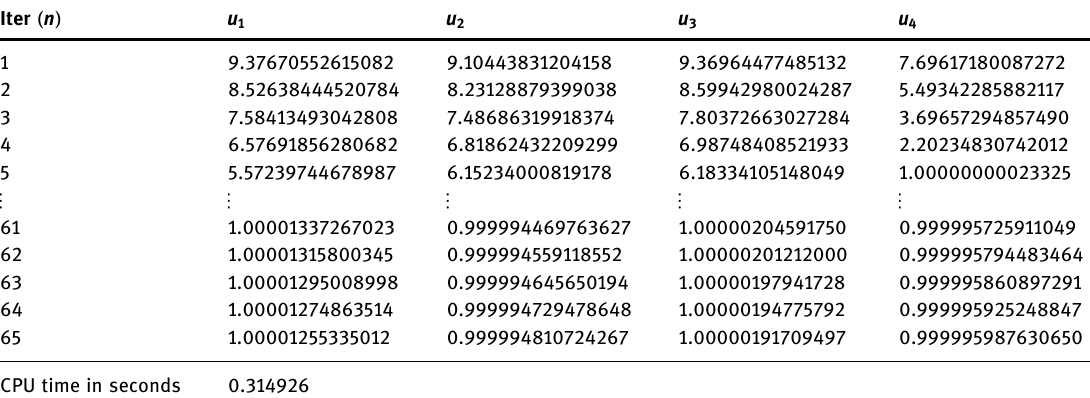
Table 4: Example 4.2: Numerical study of Algorithm 1 and